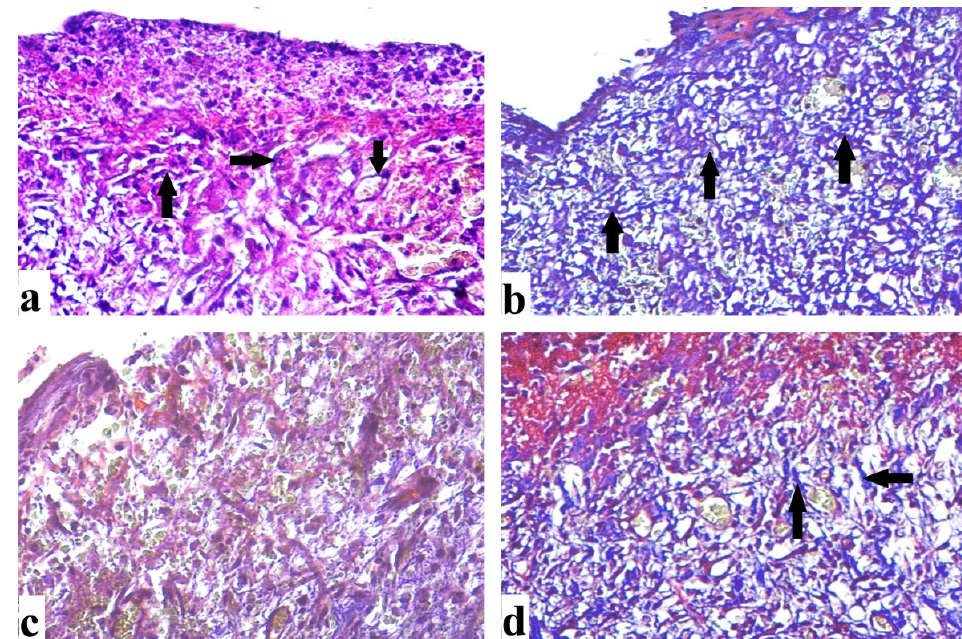
Figure 9. Sections were taken from a skin wound on day 7. ( a ) Untreated wound exhibited thin collagen fibers (arrow) aligned in different orientations. ( b ) DEEL-treated wound showed moderate collagen fibers (arrow). ( c ) An MRSA-infected lesion revealed immature irregular collagen fibers. ( d ) MRSA-infected lesion with DEEL treatment showed moderate irregular collagen fibers (arrow) (Mallory trichromeX200).